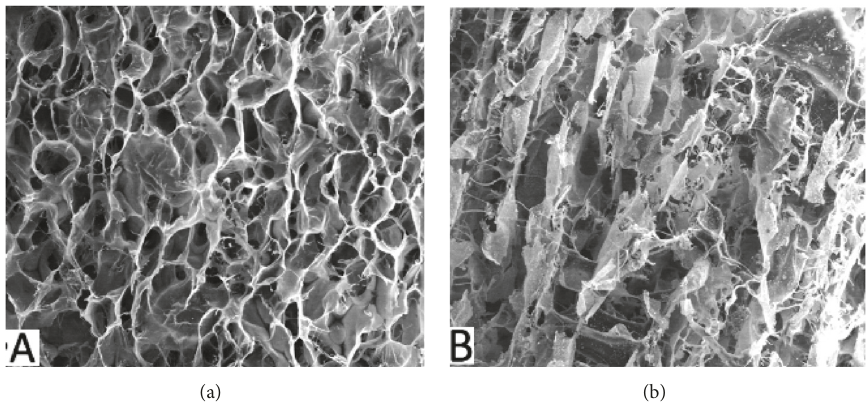
Figure 2: Cross-sectional examination of scaffold using SEM. (a) SBCS group and (b) DSBCS group.